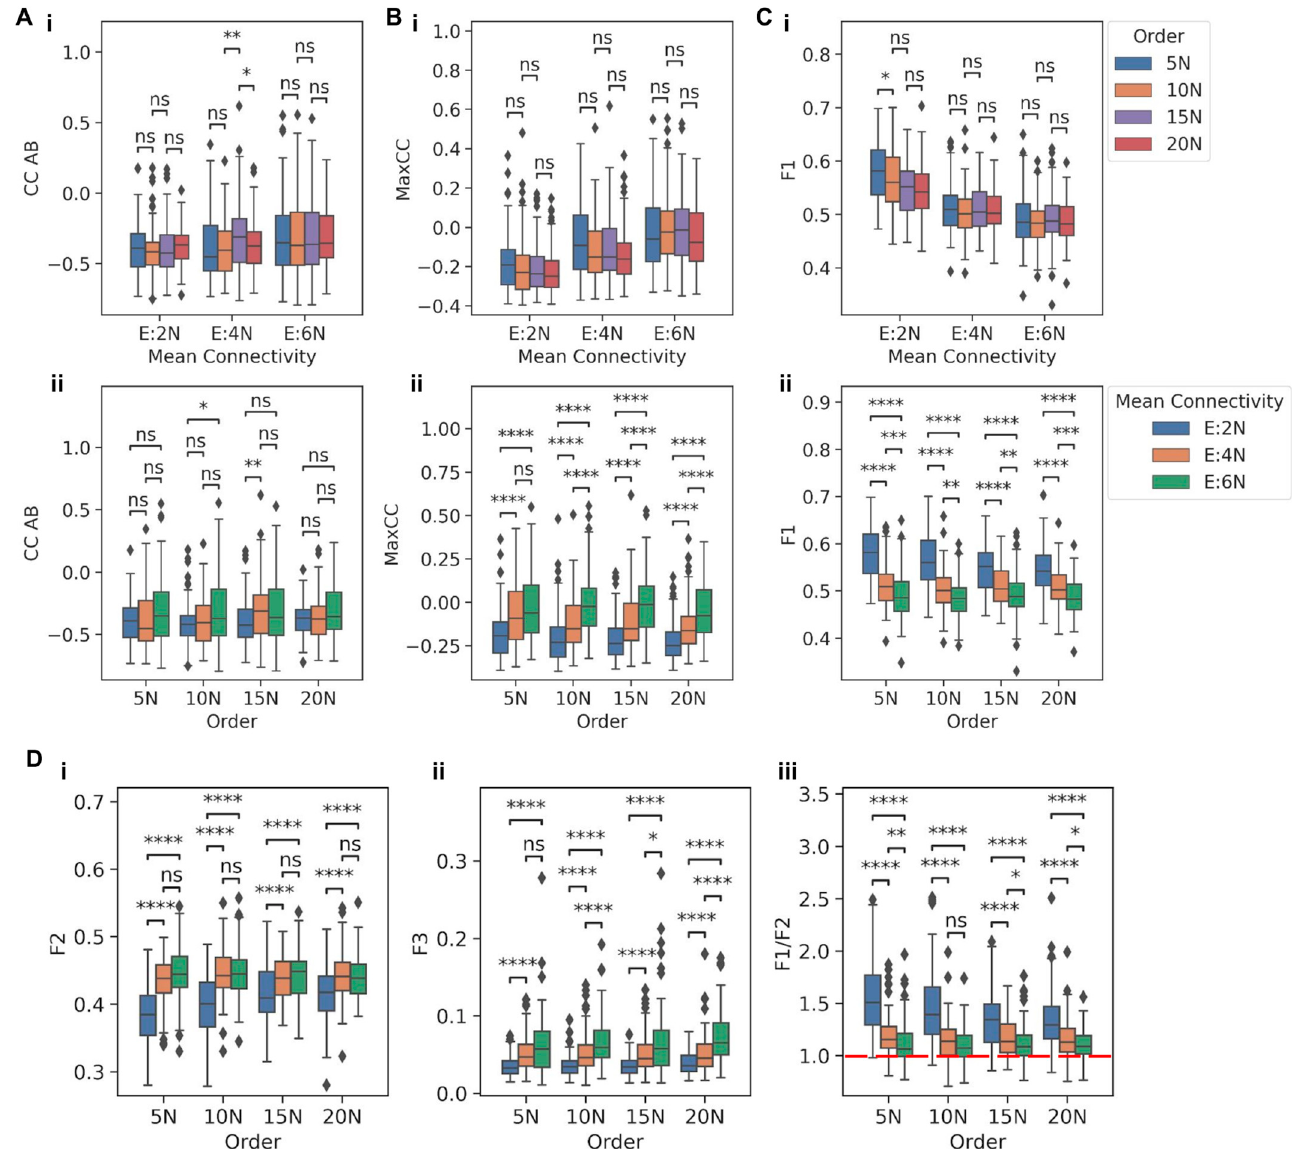
Figure 5. Functional traits of TT embedded in larger networks. ( A ) Comparison between distributions of CC AB for TT embedded in (i) networks of same mean connectivity but having different orders and (ii) networks of same order having different mean connectivity. ( B ) Comparison between the distributions of MaxCC for TT embedded in (i) networks of same mean connectivity but having different orders and (ii) networks of same order having different mean connectivity. ( C ) Comparison between the distributions of the F1, for TT embedded in (i) networks of same mean connectivity but having different orders and (ii) networks of same order having different mean connectivity. ( D ) Comparison of the distributions of (i) F2 (ii) F3 (iii) F1/F2 for TT embedded in networks of the same order having different mean connectivity. p -values of pairwise Mann-Whitney U tests are denoted by: ns— p <= 1, *—0.01< p <= 0.05, **—0.001 < p <= 0.01, ***—0.0001 < p <= 0.001, ****— p <= 0.0001.